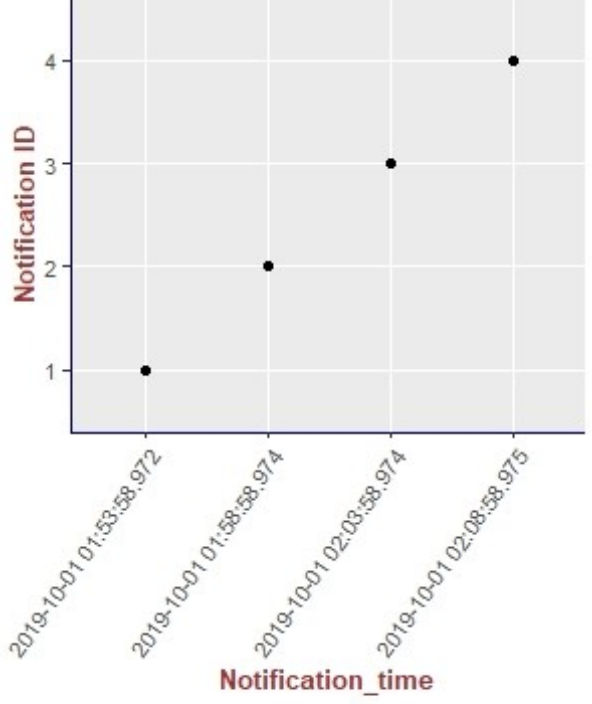
Figure 17. Illustration of the results of the delivery process related to all our experiments.